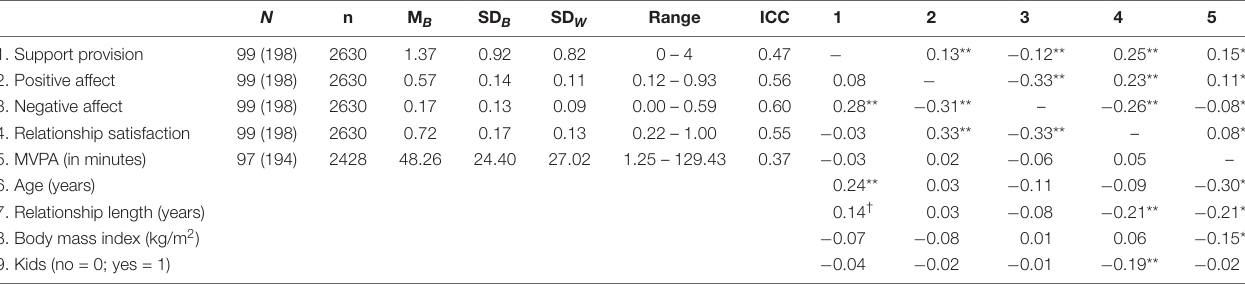
TABLE 1 | Available data, descriptive statistics, and correlations between variables of interest. N n M B SD B SD W Range